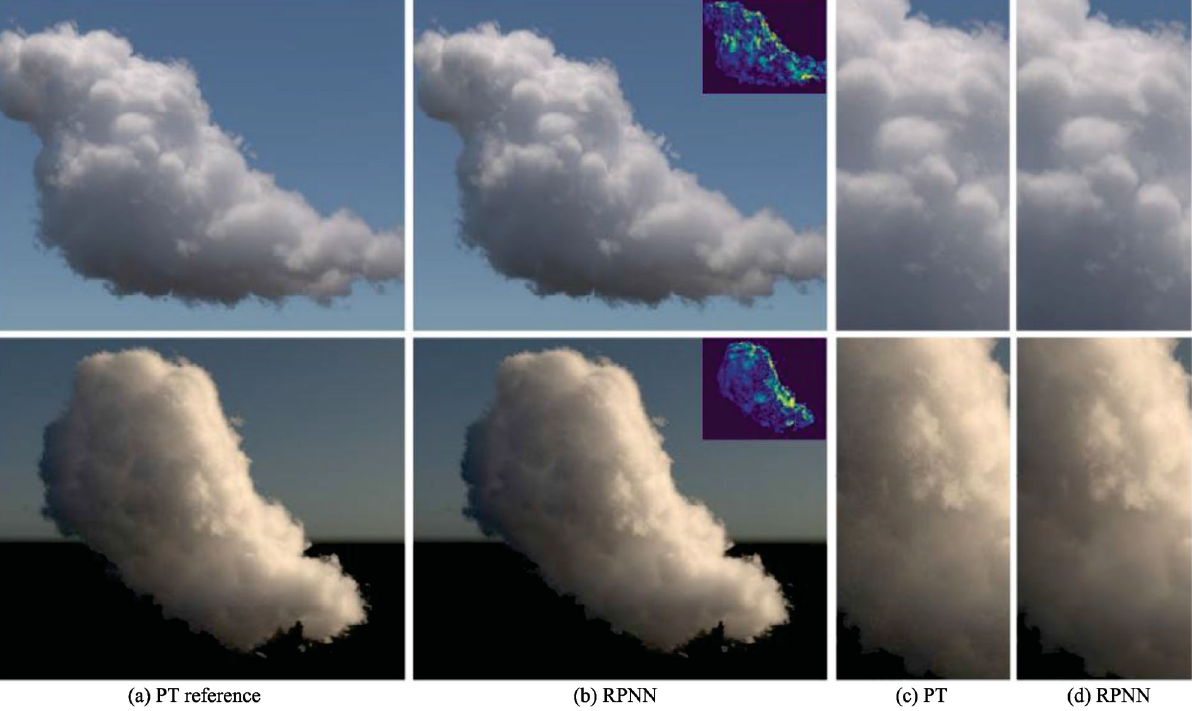
Fig. 17 Comparison of path-traced references and RPNN approach. Reproduced with permission from Ref. [64], c (cid:2) The Author(s)